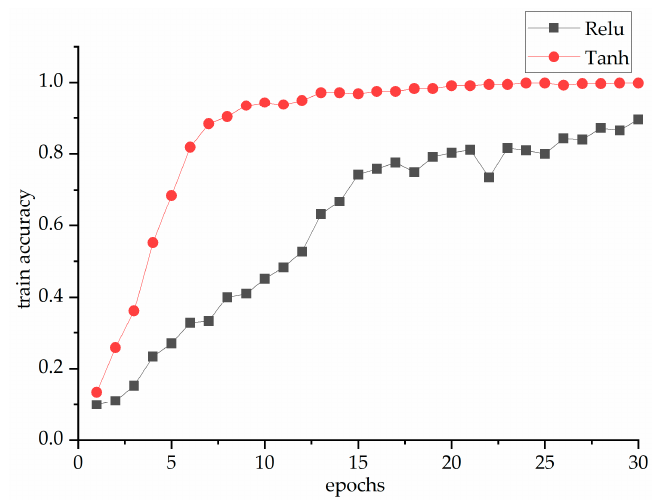
Figure 8. Accuracy during the training set with Tanh and Relu.